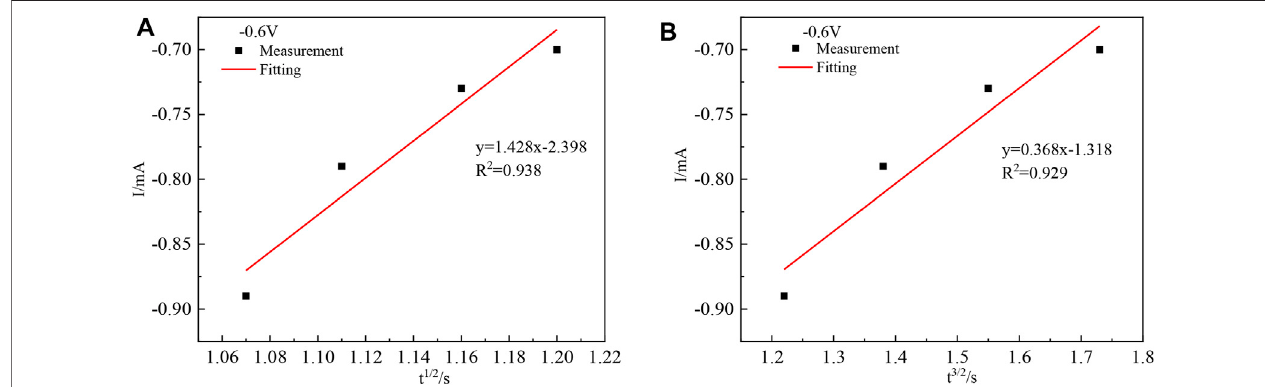
FIGURE 7 | Relationship between I ( t )- t 1/2 (A) and I ( t )- t 3/2 (B) .